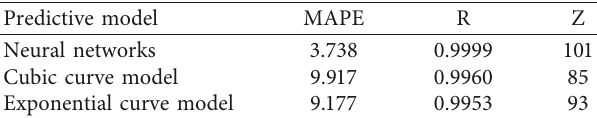
Table 6: Accuracy comparison table of simulation results of dif- ferent